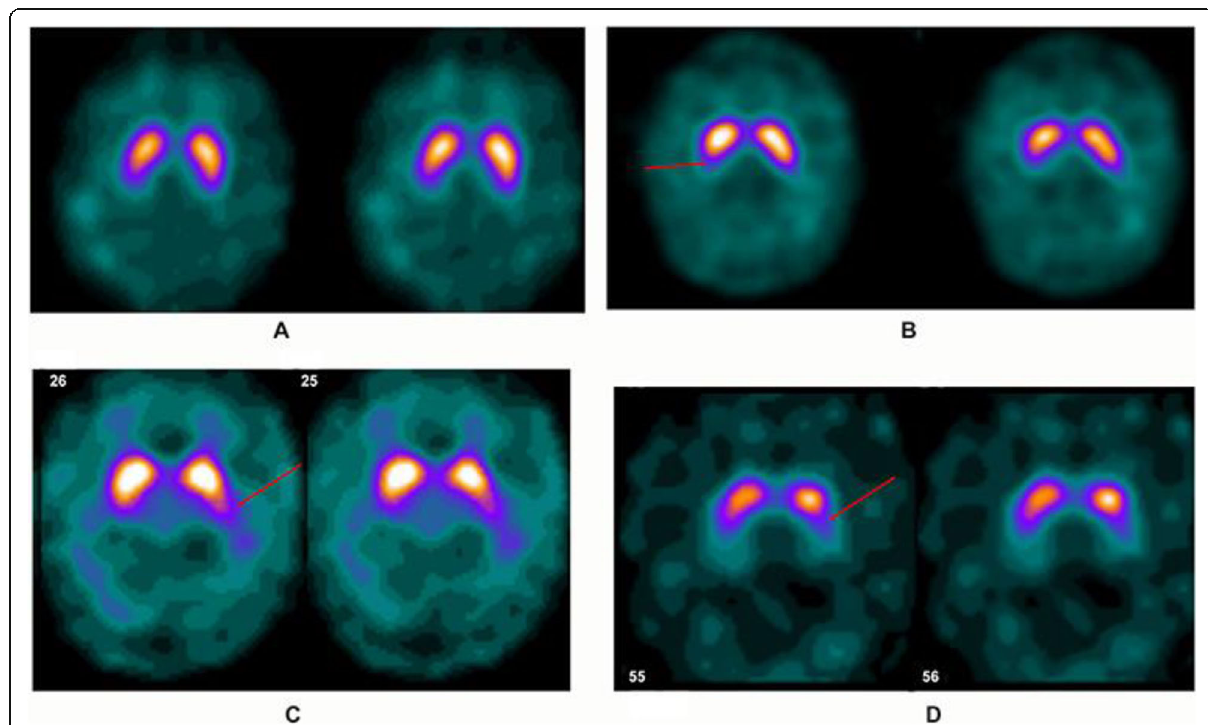
Fig. 3 DaT scan SPECT images from four patients. Image ( a ) showing normal “ comma ” configuration on the striata bilaterally, with a score of 0.